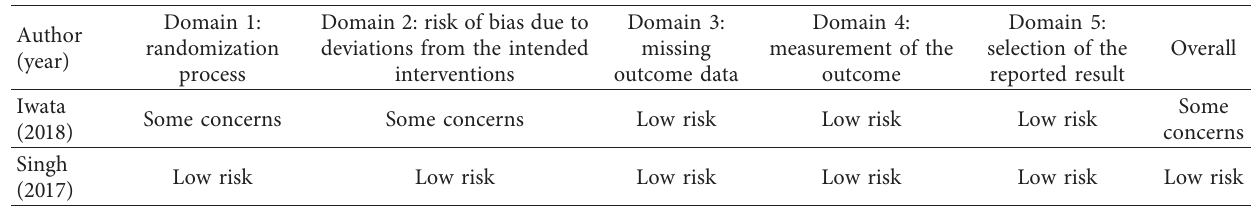
Table 3: Results of ROB 2.0 tool for risk of bias